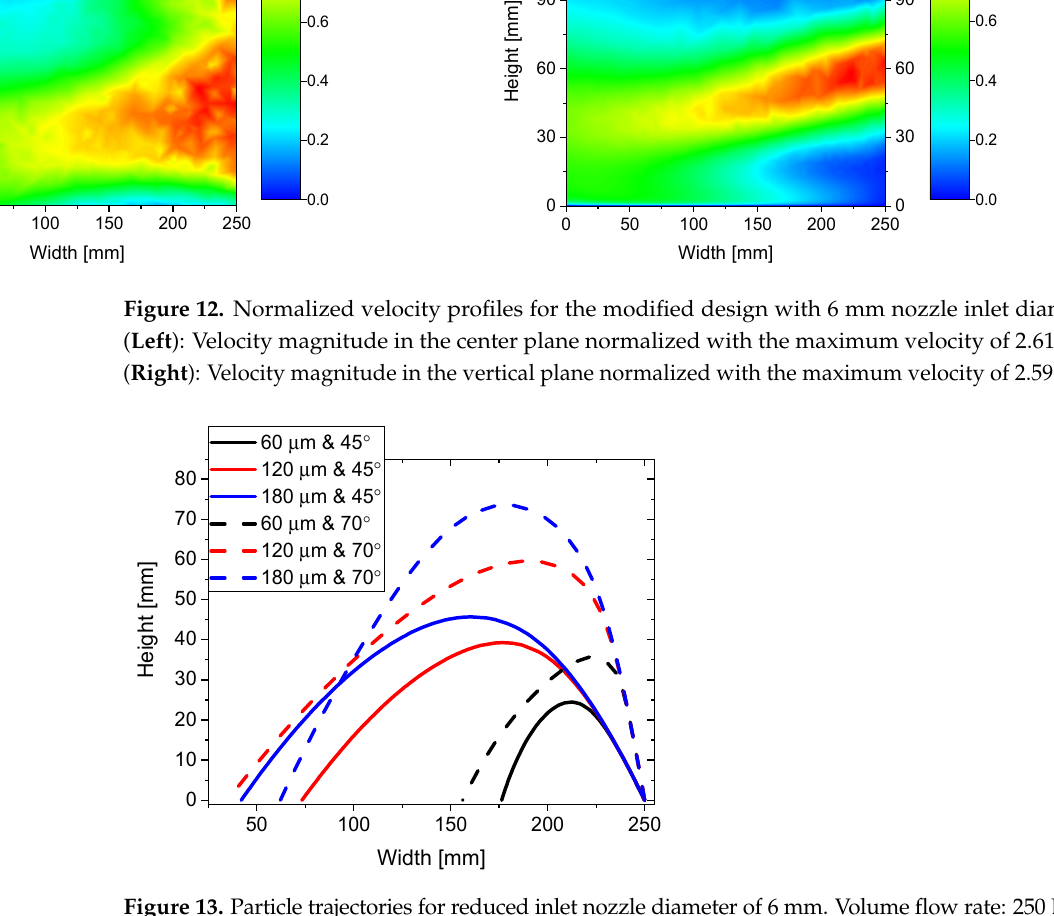
Figure 13. Particle trajectories for reduced inlet nozzle diameter of 6 mm. Volume flow rate: 250 LPM.